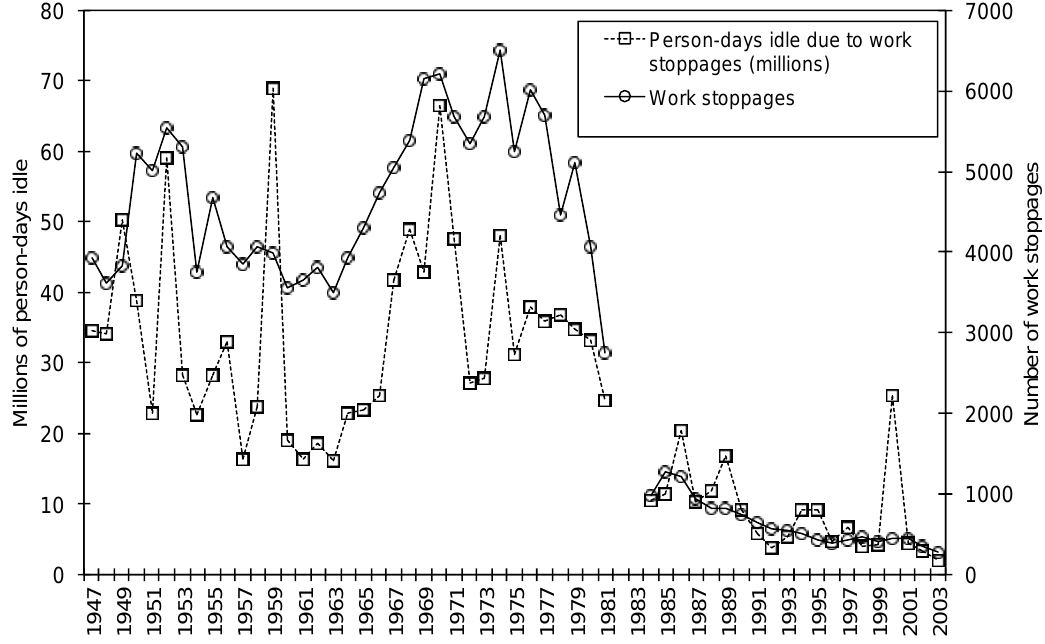
Figure 2. Strike Activity in the United States, 1947 – 2003.